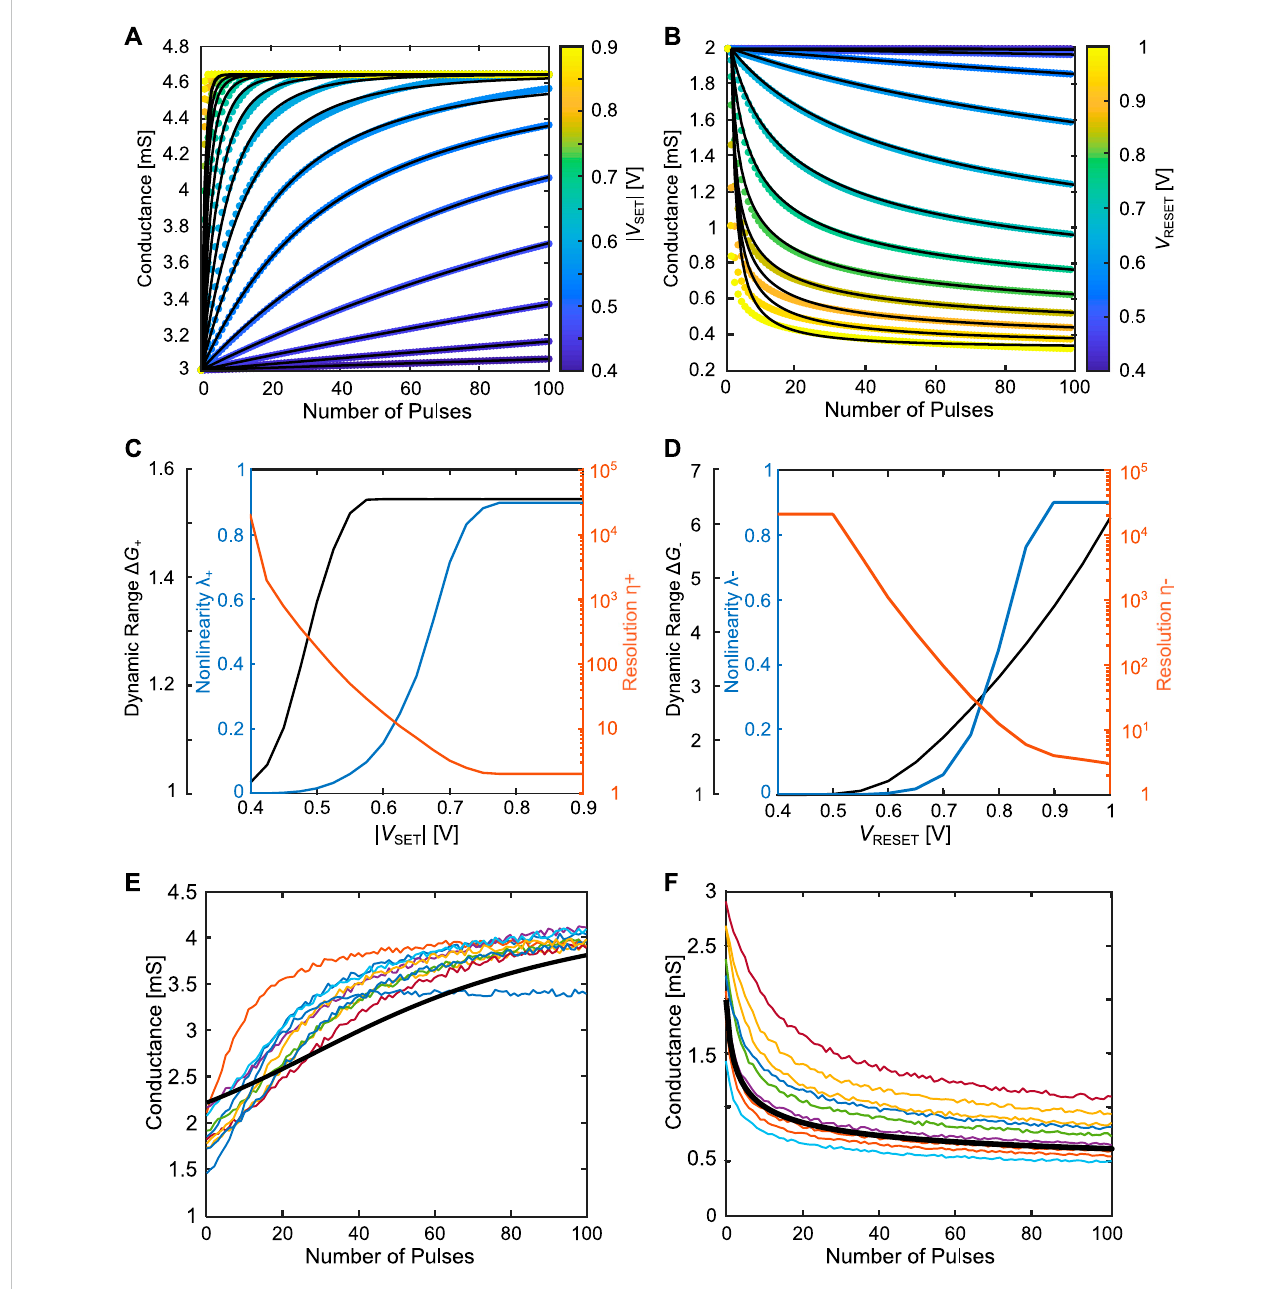
FIGURE 5 Simulated synaptic dynamics of the saturation regime of the 1R synapse for different applied pulse voltages for (A) potentiation and (B) depression. The voltagesinpotentiationdirectionwerebetween − 0.4 Vand − 0.9 Vwith25 mVstepsandthevoltagesindepressiondirectionwerebetween0.4Vand1 Vwith 50 mVsteps.TheVCMcellisinitializedat G linear,min =2 mS(fordepression)and G linear,max =3 mS(forpotentiation).Thecorrespondingdynamicranges,non- linearity and resolution are shown in (C) for potentiation and (D) for depression. In (E) and (F) we have simulated ten potentiation and depression curves with the variability of the improved device as explained in section 2.1. The deterministic curve is shown as the thicker black curve. The potentiation voltage was − 0.5 V and the depression voltage was 0.8